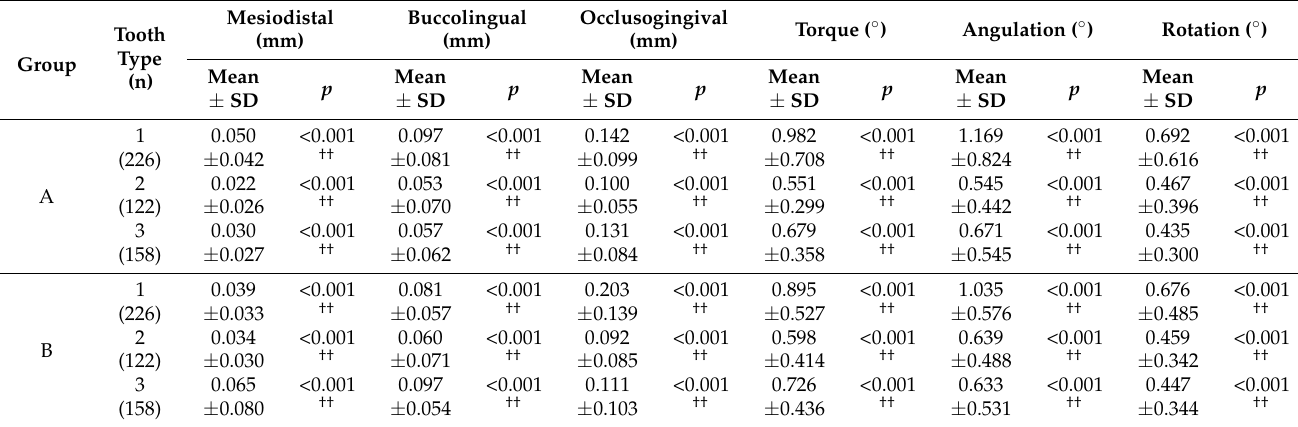
Table 1. Difference between the reference position and the actual bracket placement after indirect bonding for each experimental group.